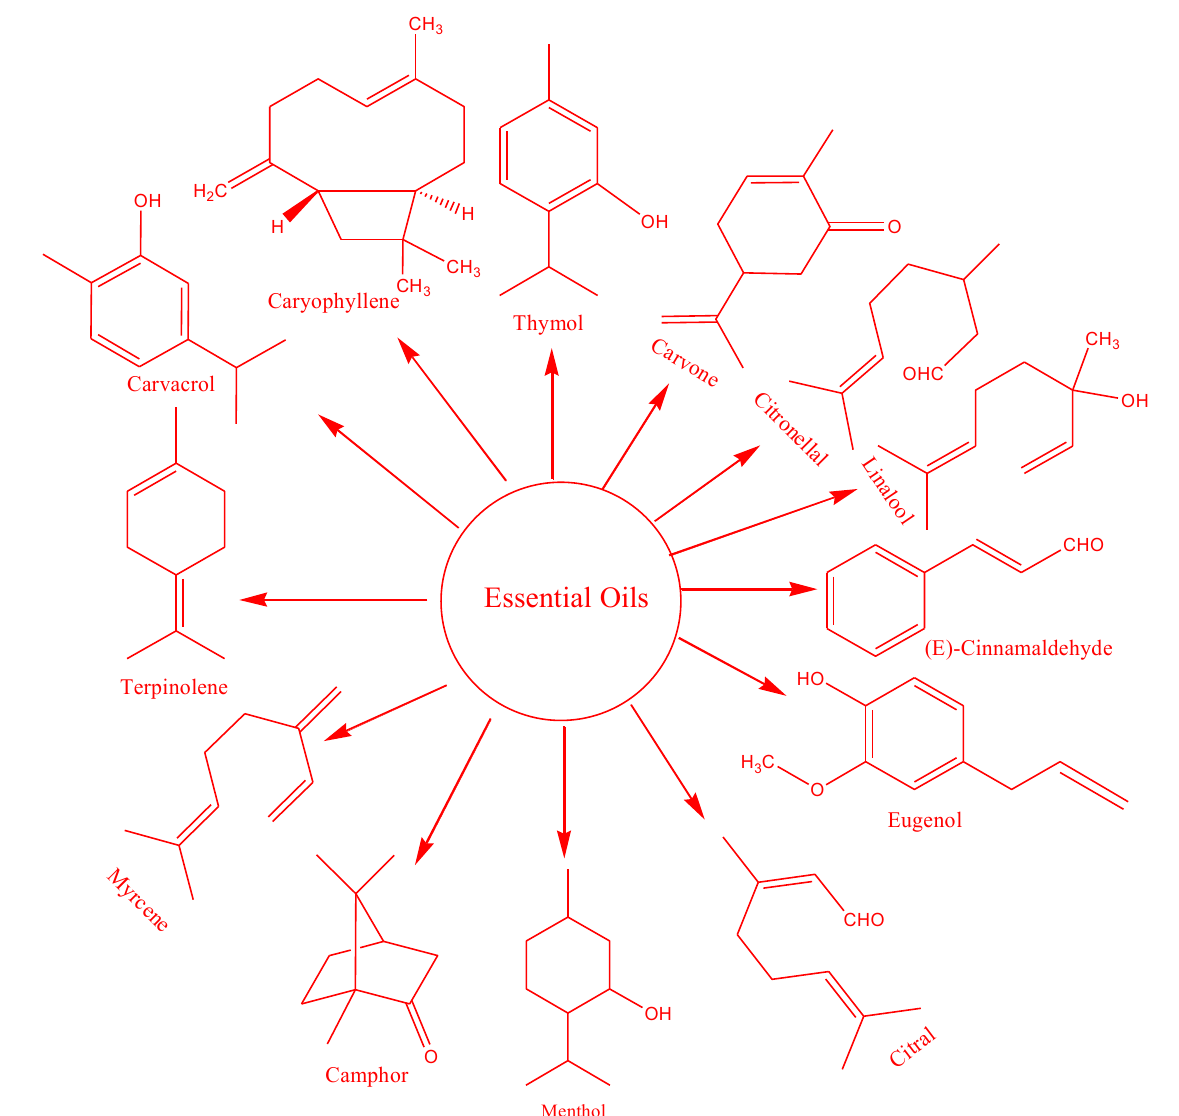
Figure 1. Active ingredients of essential oils.